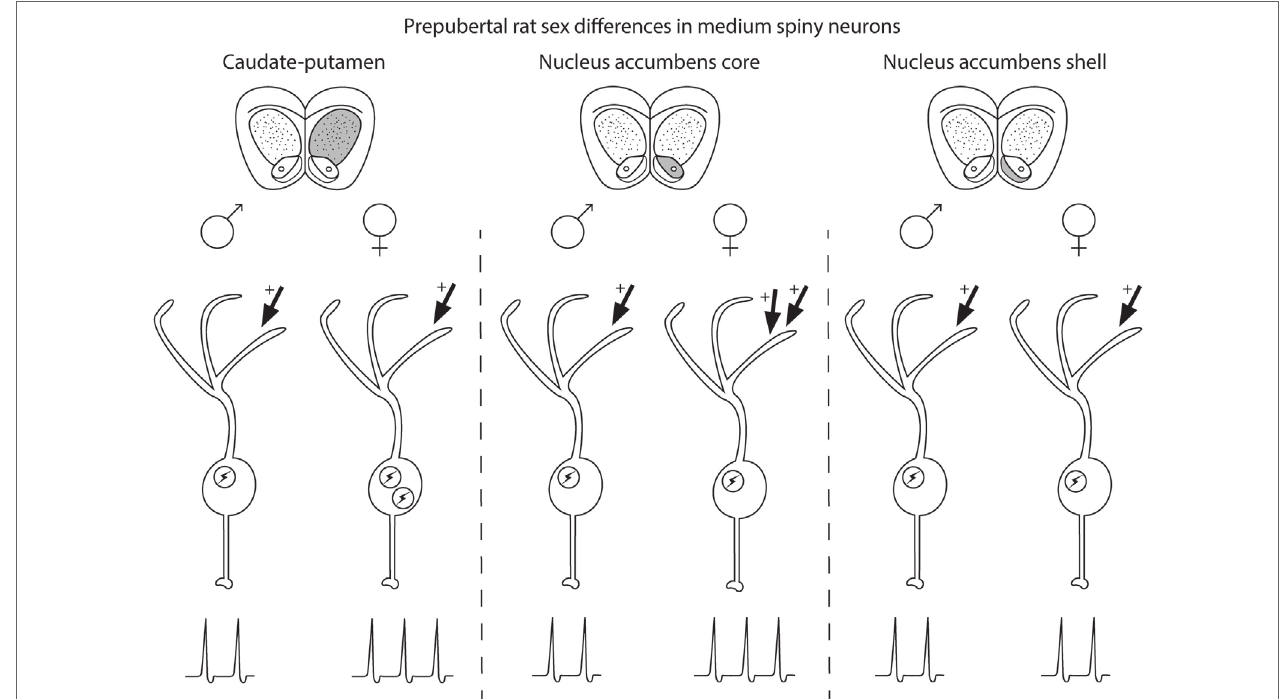
FiGURe 1 | Schematic of sex differences in medium spiny neurons (MSNs) in prepubertal rat caudate–putamen, nucleus accumbens core (AcbC), and nucleus accumbens shell (AcbS). In general, MSNs recorded from prepubertal female rats exhibit increased excitation compared with male MSNs in the caudate–putamen and nucleus AcbC. However, the exact nature of the increased excitability in female MSNs differs by striatal region, encompassing changes in either intrinsic excitability (indicated in the schematic with an encircled lightning bolt) or excitatory synaptic input (indicated with arrows with plus signs). Differences in intrinsic excitability and excitatory synaptic input are indicated with more or less lightning bolts and arrows, respectively. Caudate–putamen MSNs show increased intrinsic excitability in prepubertal females compared with males. Nucleus AcbC MSNs receive augmented excitatory synaptic input in prepubertal females compared with males. Nucleus AcbS MSNs exhibit little evidence for sex differences in either intrinsic excitability or excitatory synaptic input in prepubertal